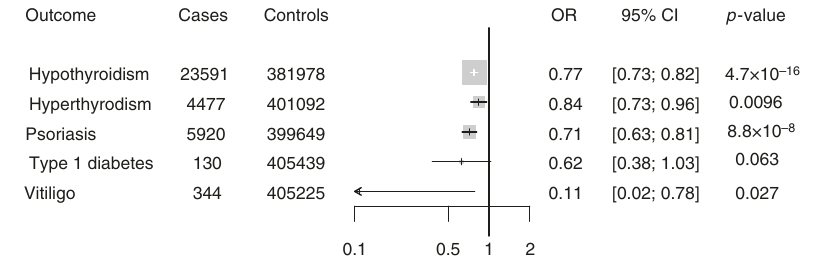
Fig. 4 Association of predicted loss-of-function variants in IFIH1 with thyroid disorders, type 1 diabetes, psoriasis, and vitiligo in UK Biobank. Estimates were derived in UK Biobank using logistic regression, adjusted for age, sex, ten principal components of ancestry, and array type